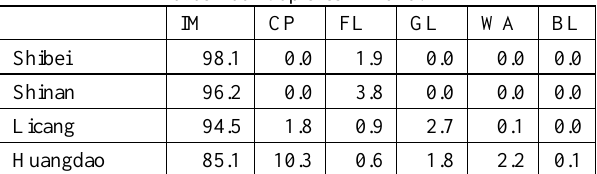
Figure 3 . The area proportions of different land cover types in urban built-up area in 2010.